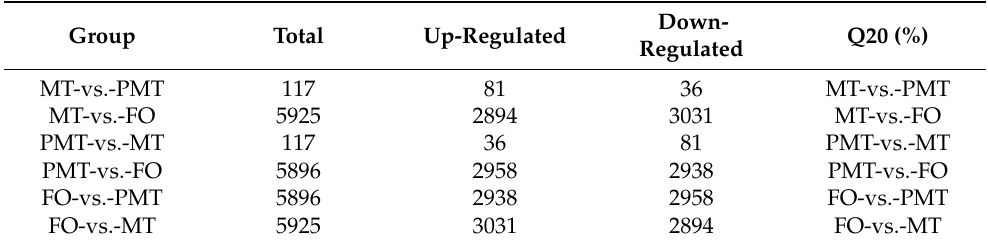
Table 5. Differentially expressed genes among the gonadal tissues of males, pseudo-males, and fe- males. Down- Q20 (%) Group Total Up-Regulated Regulated MT-vs.-PMT 117 81 36 MT-vs.-PMT MT-vs.-FO 5925 2894 3031 MT-vs.-FO PMT-vs.-MT 117 36 81 PMT-vs.-MT PMT-vs.-FO 5896 2958 2938 PMT-vs.-FO FO-vs.-PMT 5896 2938 2958 FO-vs.-PMT FO-vs.-MT 5925 3031 2894